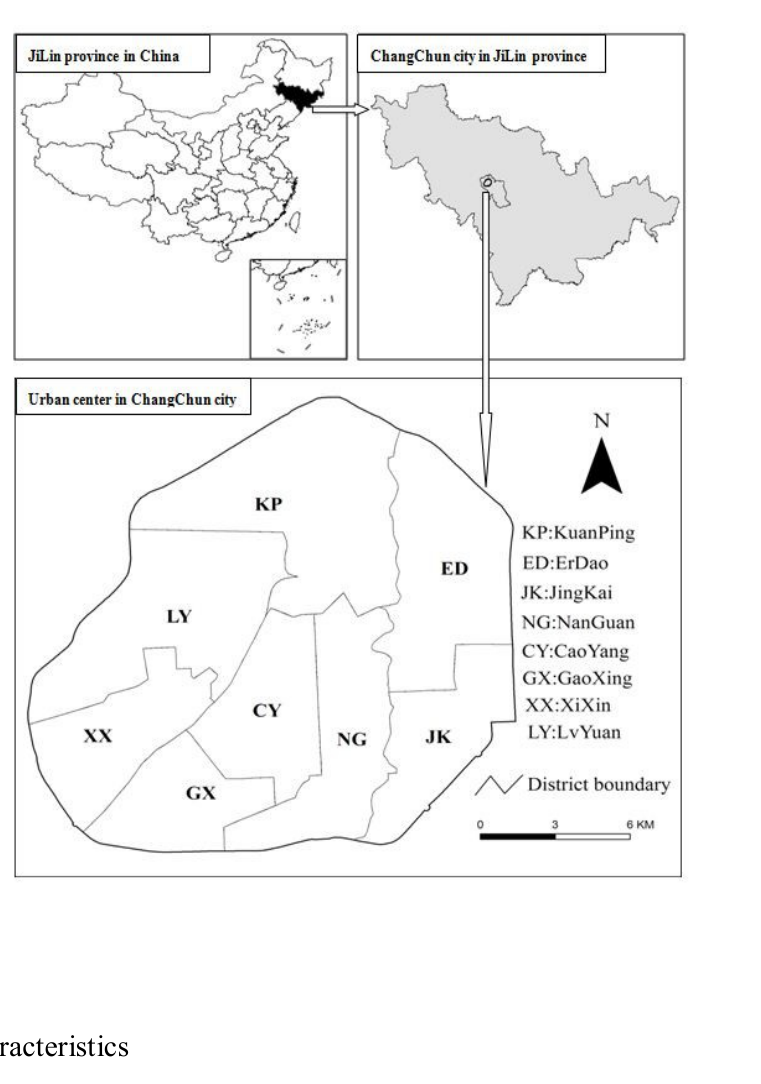
Figure 1. The study area: areas within the fourth-ring road of Changchun,